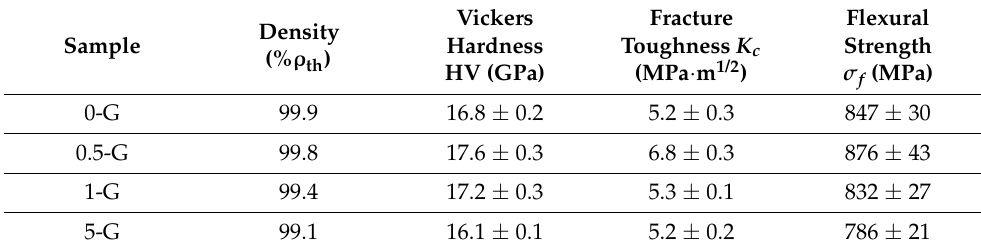
Table 2. Mechanical properties and density of Al 2 O 3 -ZrO 2 /rGO composites.